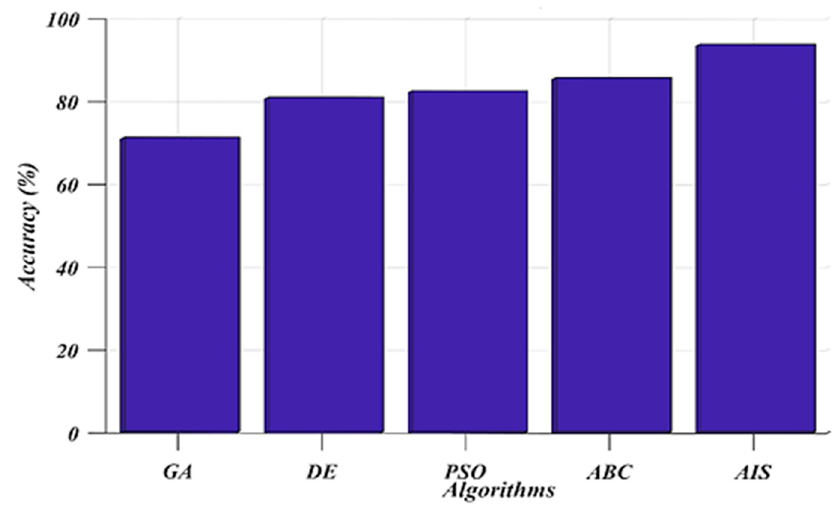
Figure 9. Accuracy Evaluation for Hepatitis.